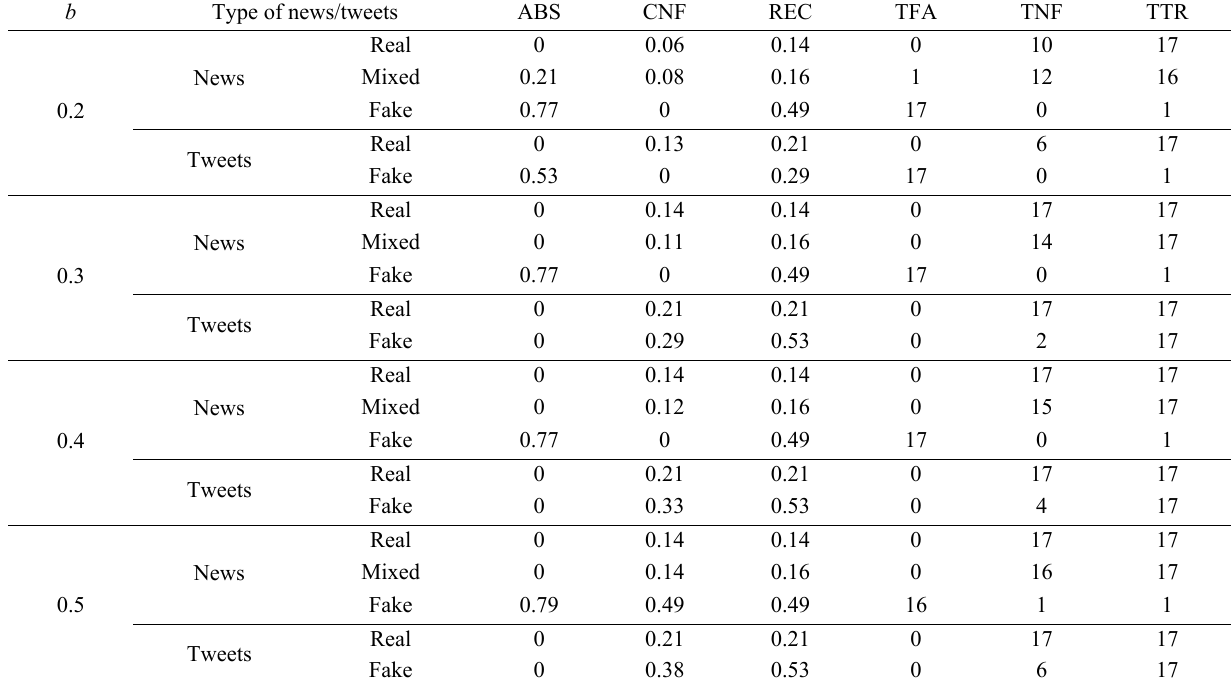
Note: TFA, TNF, and TTR refer to the month-based average values. Table 9 Absorption (ABS), community non-functioning (CNF), recovery (REC), time for absorption (TFA), time under community non-functioning (TNF), and time to recovery (TTR) for news and tweets with the critical economic functionality threshold b varying over the range of